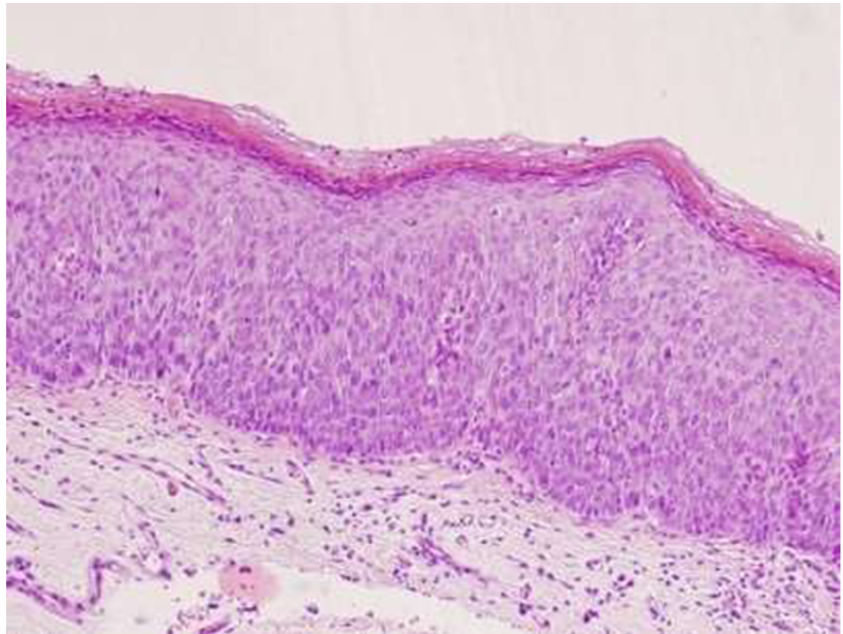
Figure 4. High-grade anal squamous intraepithelial neoplasia (AIN2+), 40×. Courtesy of Dr. Mauri- cio Iribarren, General Surgery Department, Álvaro Cunqueiro Hospital, Vigo.